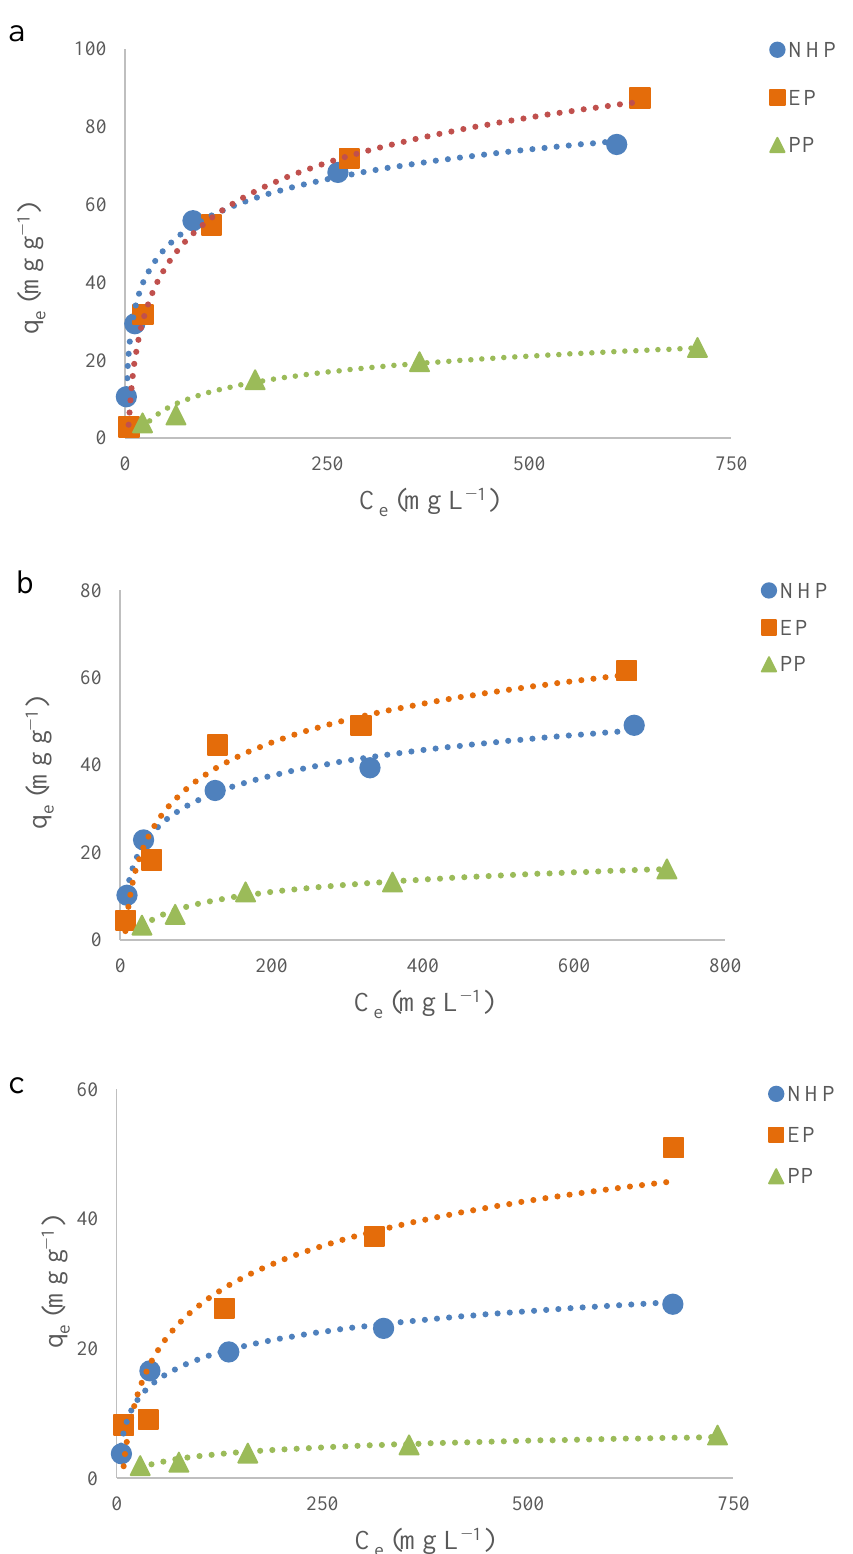
Figure 4. Comparison of equilibrium concentration of EGCG (C e ) and adsorption capacity (q e ) between NHP, EP and unprocessed pomelo peel (PP) at 25 ( a ), 40 ( b ) and 55 ◦ C ( c ). The data for unprocessed pomelo peel are from reference